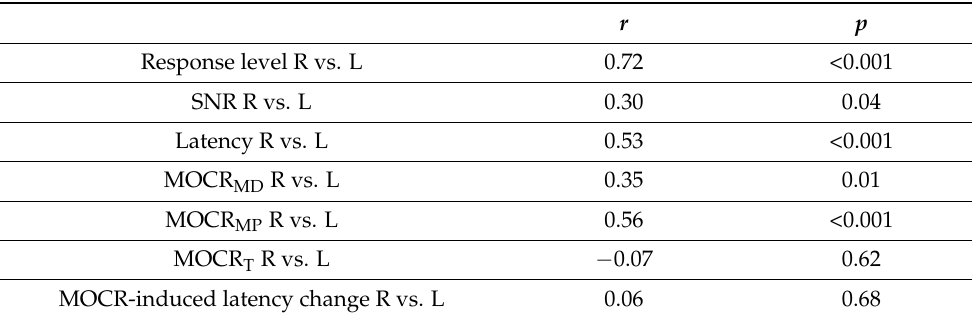
Table 3. Correlations between ears of TEOAE parameters and MOCR estimates (measured over the whole year). Latency measurement derives from 1 kHz band; all other parameters are derived as global (broadband) values. R, right; L, left.